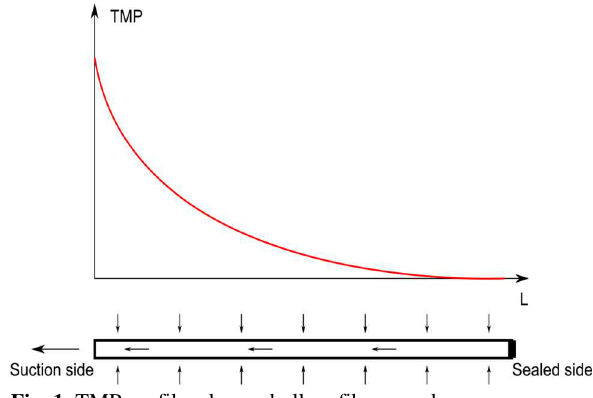
Fig. 1. TMP profile along a hollow fiber